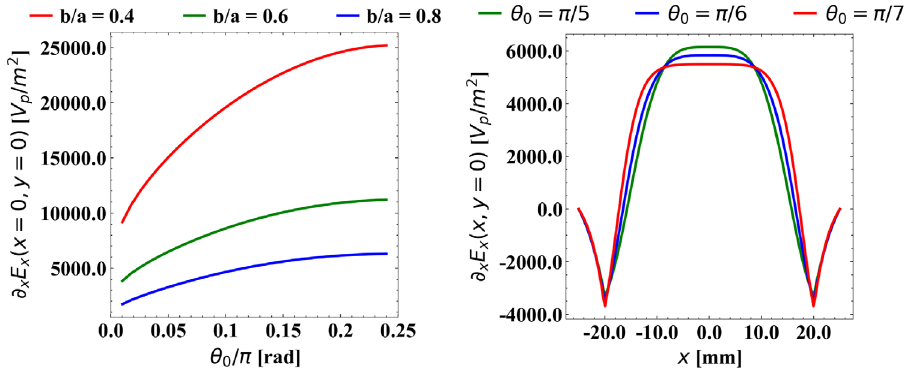
= ∂ x at the origin as a function of θ 0 (left) and along the x-axis between the x